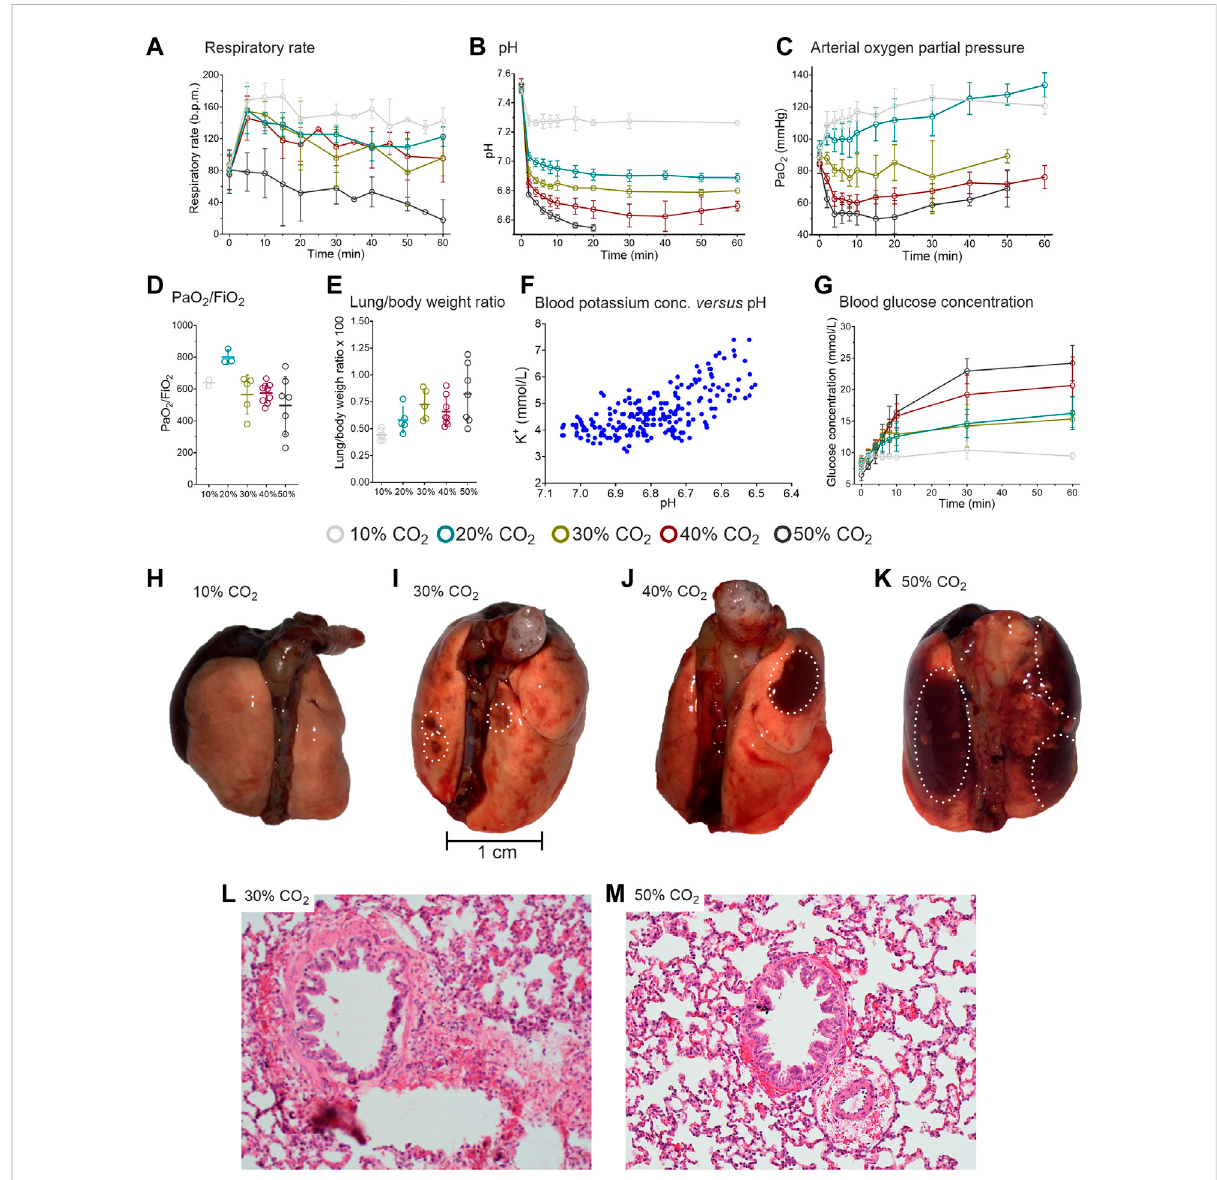
FIGURE 2 Results of the rat experiments. (A) Respiratory rate during the 1-h inhalation of 10, 20, 30, 40 or 50% CO 2 . (B) pH during CO 2 inhalation. During 50% CO 2 inhalation 5/8 animals died after 14 – 25 min. In the remainder of animals, no pH samples were obtained beyond 20 min (C) Arterial oxygen concentrations. (D) Arterial PO 2 /FiO 2 ratio in the different CO 2 exposure groups. (E) Lung/body weight ratio in the different CO 2 exposure groups. different CO 2 exposure groups. (F) Blood potassium concentration versus pH. (G) Blood glucose concentration in the various CO 2 exposure groups. (H-K) . Macroscopic aspect of the lungs of three distinct animals that inhaled 1-h of 10%, 30% and 50% CO 2 . The white circles indicate the location of hemorrhages. l and m. Microscopic aspect of lung sections of two distinct animals treated with 30% (I) and 50% (M) CO 2 . Peribronchiolar and perivascular hemorrhages are present as well as emphysema throughout the section. The slices in panels l and m are 200-times magni fi ed and stained with hematoxylin and eosin. The data in panels a-c and g are mean ± SD, in panels d and e median (50 – 75% interquartile) are